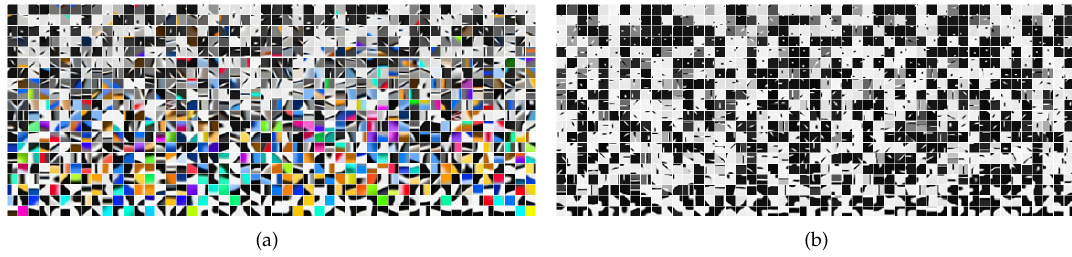
Figure 7. The learned color codebook ( a ) and depth codebook ( b